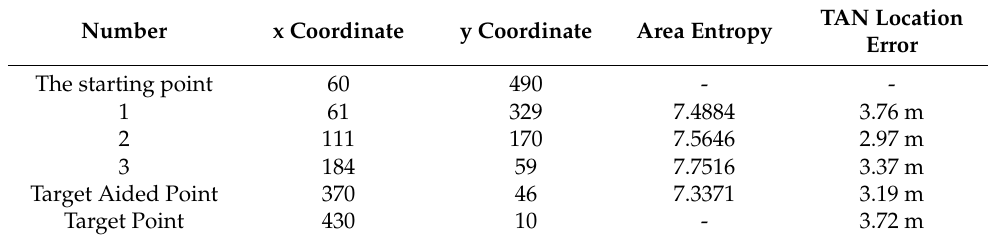
Table 9. Data of each point searched on the route of the first group of starting and ending points.